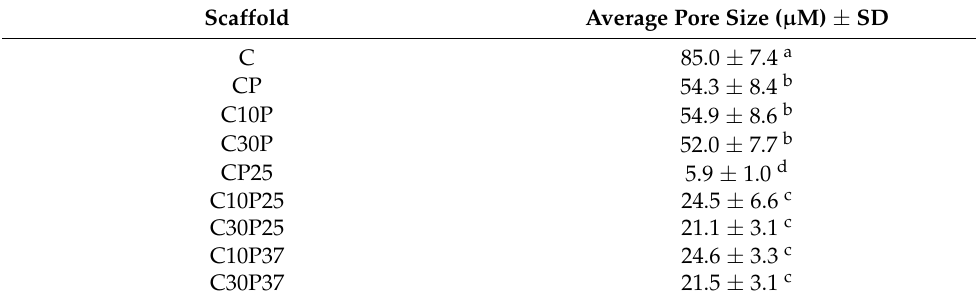
Figure 9. SEM Micrographs of collagen scaffold and calcium phosphate mineralization. ( A ) CP25; ( B ) C10P25, with respective EDX insert; ( C ) C30P25 (Magnification of 700 × ) and ( D ) C30P25 (Magnification of 12,000 × ). Table 4. Scaffolds average pore